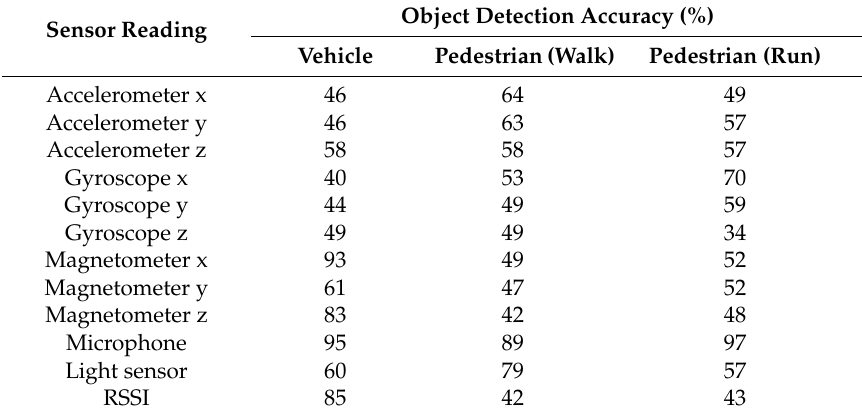
Table 6. Accuracy of object detection based on individual sensor readings from SN1. Sensor